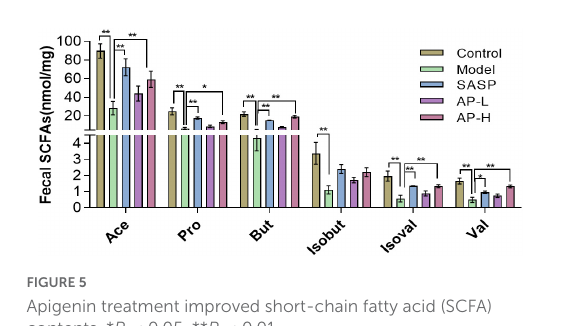
FIGURE5 Apigenin treatment improved short-chain fatty acid (SCFA) contents. * P < 0.05, ** P <